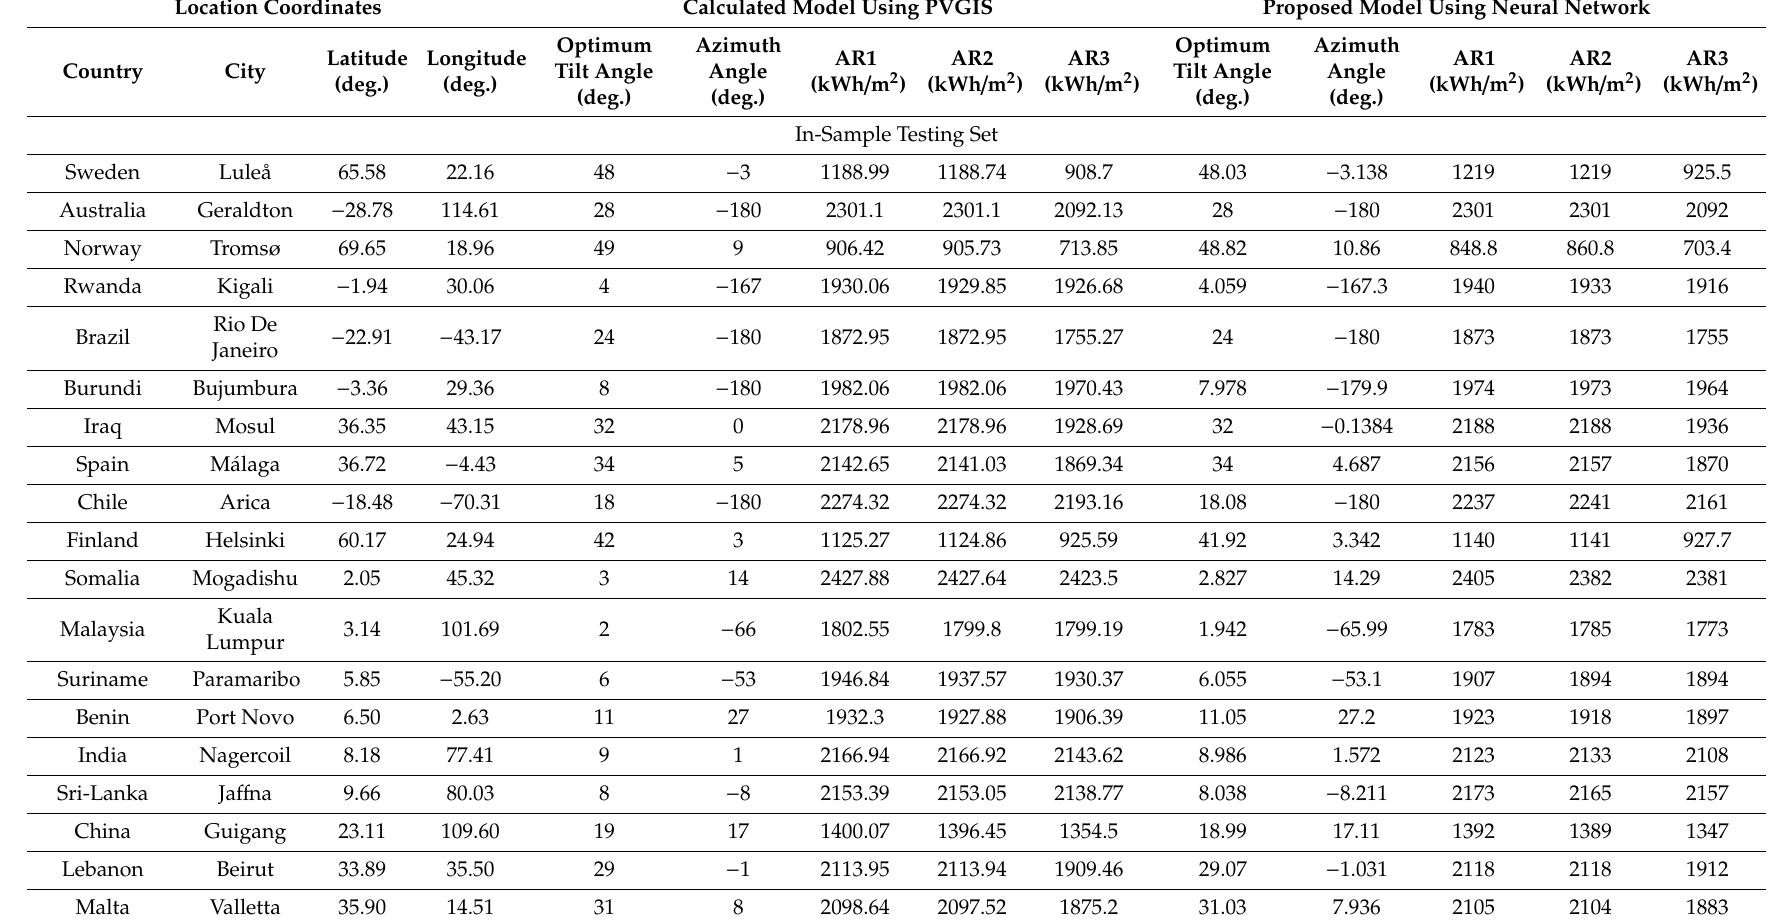
Table A2. In-sample and out-of-sample proposed model